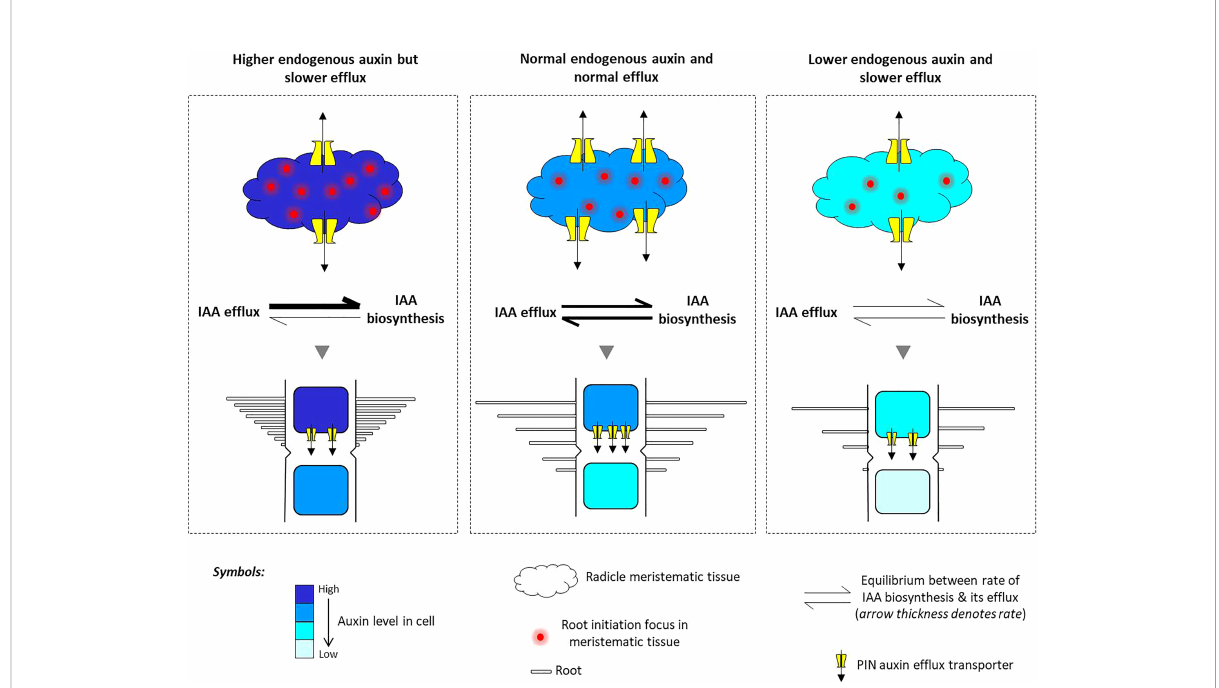
FIGURE 11 A model of PIN-mediated determination of auxin fl ow and its role in shaping an auxin-dependent root architecture in rice. The meristematic cells present in the radicle of rice embryo undergo normal cell division to put forth the usual root architecture in rice seedlings. But upon experiencing high auxin in fl ow and greater auxin biosynthesis, the meristematic cells start to rapidly divide and initiate more foci of root initiation, as excess auxin cannot be quickly fl ushed out due to the downregulation of the PIN auxin ef fl ux transporters. This results in the formation of excessive secondary roots from multiple foci of root initiation. On the contrary, when the cellular auxin level decreases by a lower IAA biosynthesis and auxin fl ow is inhibited by TIBA treatment, PIN downregulation causes a restriction in the movement of endogenous auxin, resulting in lesser meristematic cell division, lesser number of root initiation foci, and lesser secondary root formation. Overall, there exists a fi ne balance between the rate of auxin biosynthesis and their PIN-mediated ef fl ux. When in equilibrium, there is normal root production, but when equilibrium shifts toward high endogenous auxin, it favors excessive cell division and differentiation into a higher number of roots. Furthermore, the combined in fl uence of lower auxin biosynthesis and lesser auxin transportation decreases the number of